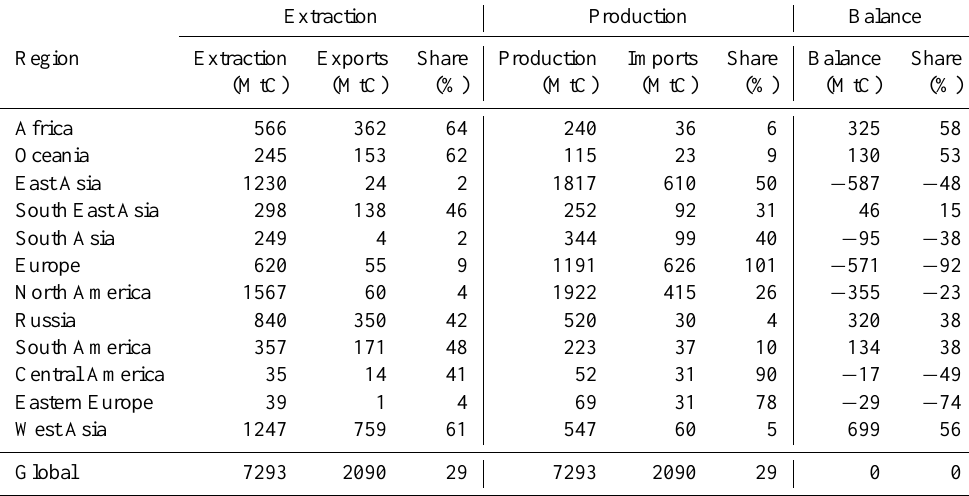
Table 8. The 2004 fossil fuel carbon extracted in each region (extraction), the amount and share exported, the consumption of fossil fuel carbon (equal to the territorial-based emissions) amount and share imported, and the difference between extraction and production (and exports and imports). Exports and imports only represent the trade between the RECCAP regions, and do not include the trade between countries within a region (e.g. Finland and Sweden). The shares are always in terms of extraction.